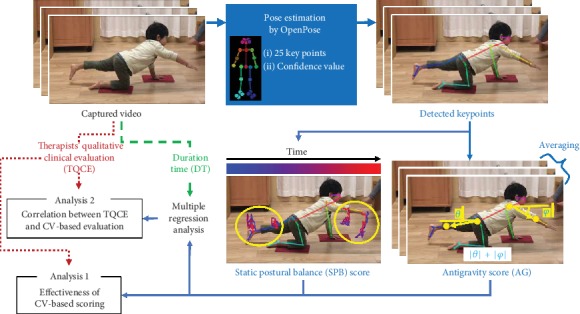
Research flowchart.